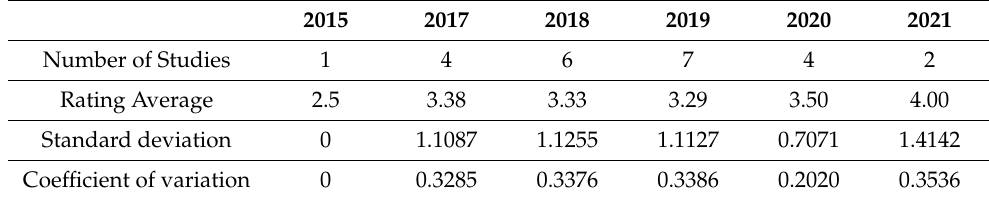
Table 3. Average study quality score by